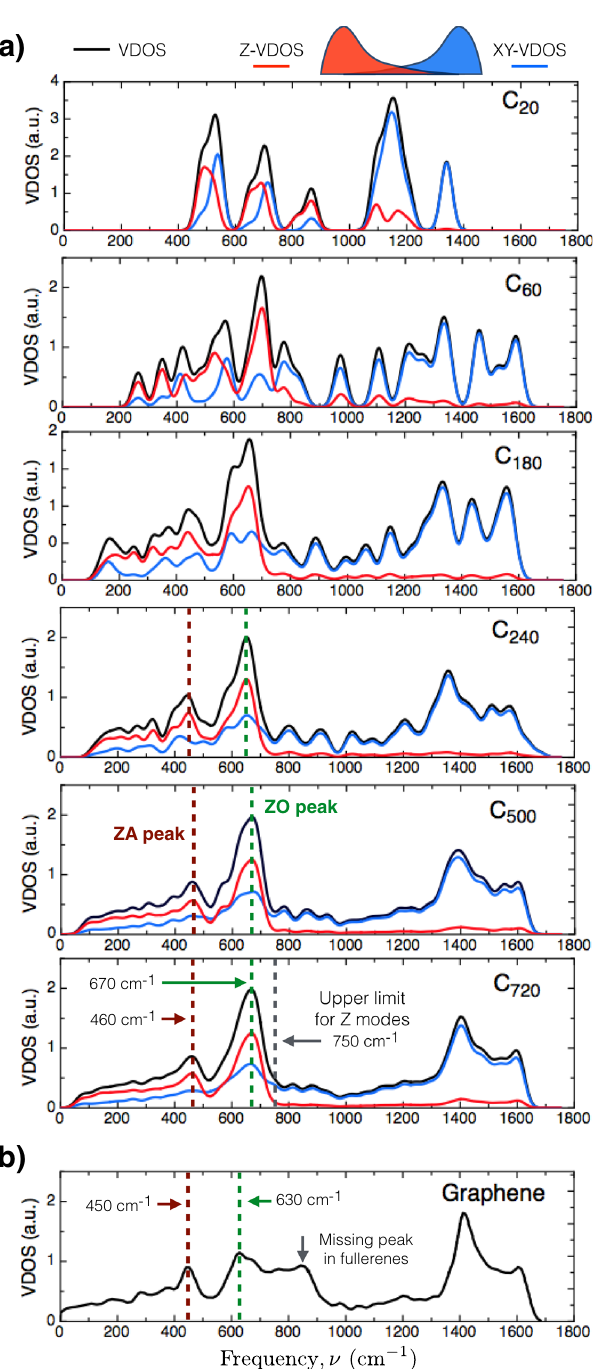
Fig. 1 Size convergence of the VDOS for the fullerene family. a Fullerenes ’ VDOS (black/enclosing curve) as a function of the diameter. The red and blue curves represent the radial and tangential contributions to the total VDOS, respectively. The VDOS was constructed using a Gaussian broadening with a width of 20 cm − 1 . b The bulk graphene VDOS was taken from ref. 65 . The ZA and ZO VDOS peaks are highlighted by dashed lines, as well as other relevant features in the